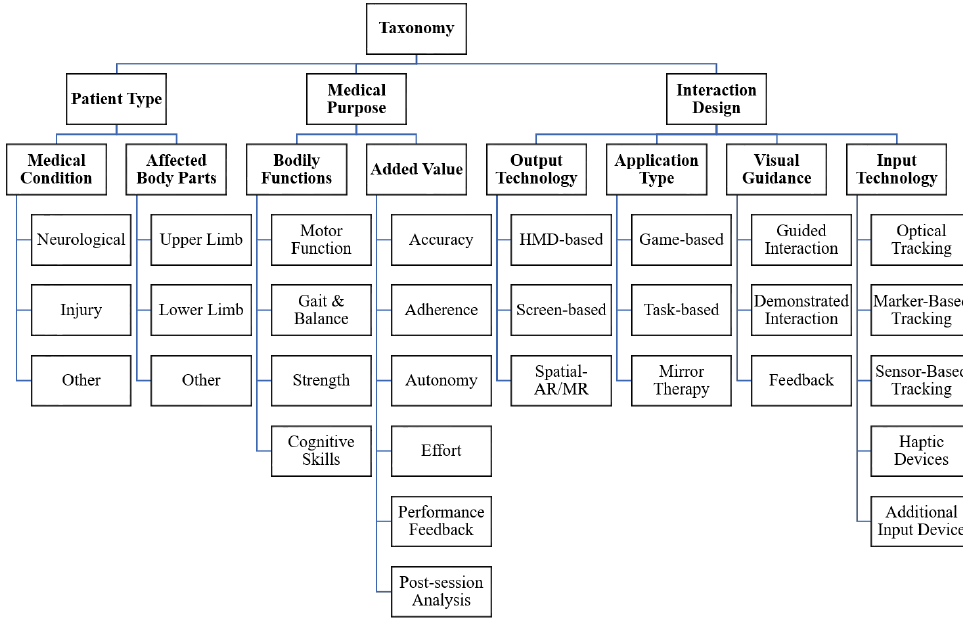
Figure 2. Overview of the